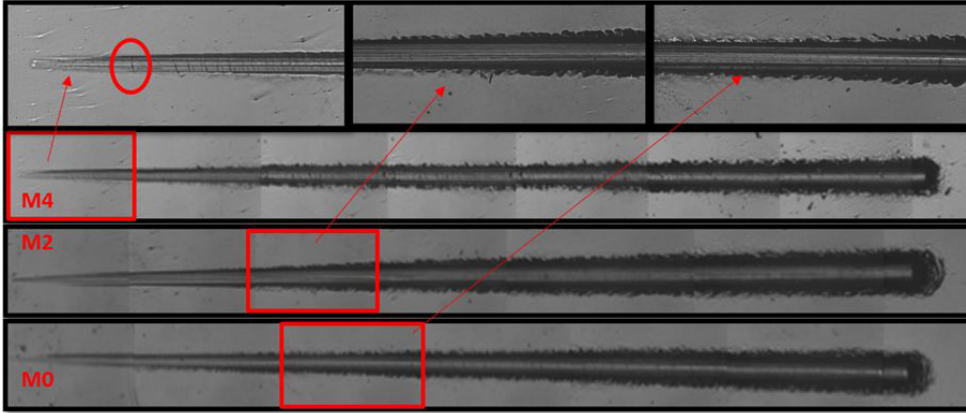
Figure 6. Optical microscopy of the scratch track of coating coatings M0, M2 y M4.